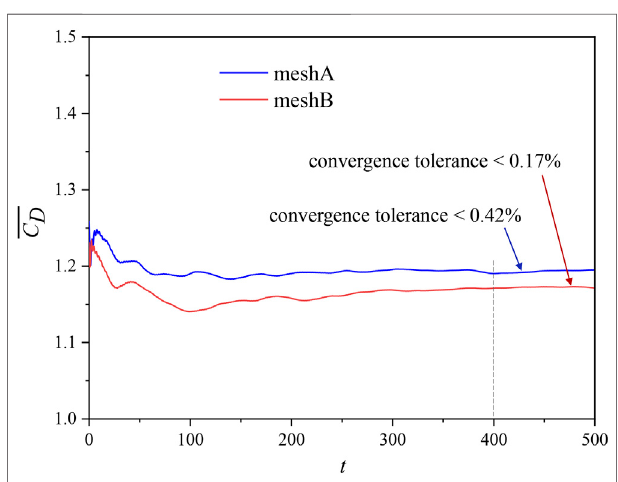
FIGURE 2 | Statistical convergence of C D (Pr =